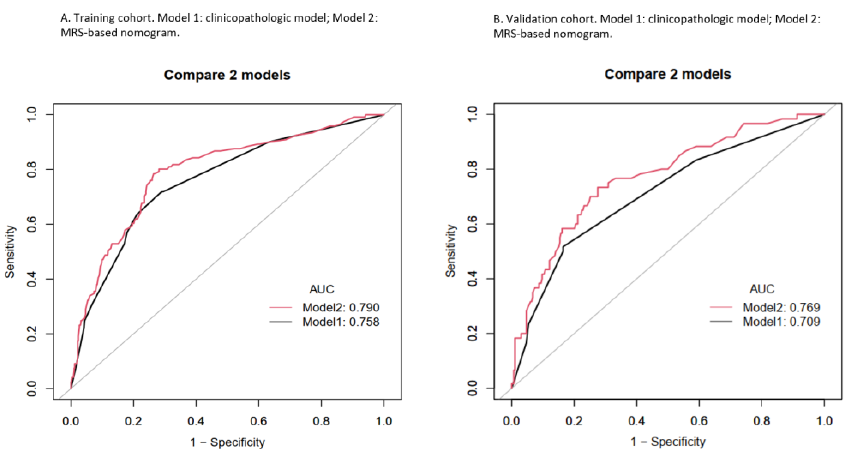
Figure 2. AUC of clinicopathologic model and MRS-based nomogram for prediction of LVSI in EC in ( A ) training cohort and ( B ) validation cohort.